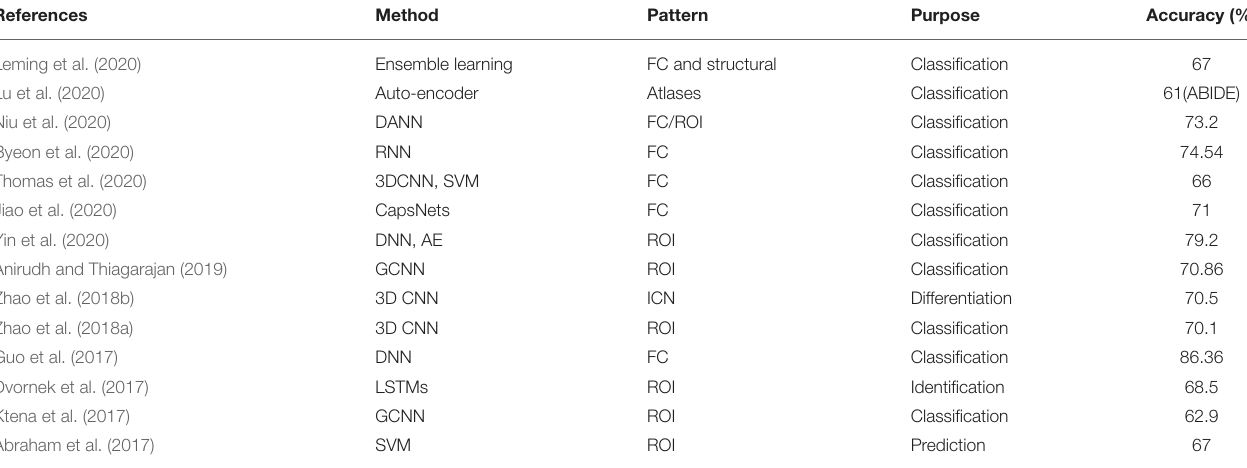
TABLE 1 | A concise representation of the erstwhile deep learning algorithms in autism classification.